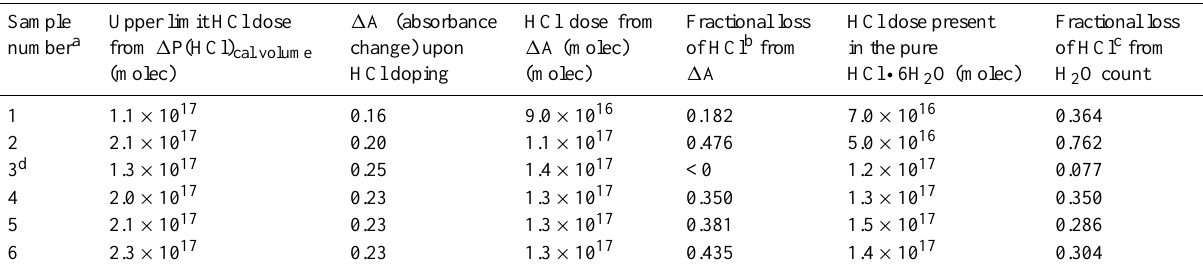
Table 4. Mass balance considerations. Comparison between the dispensed HCl dose obtained from the pressure decrease in the calibrated volume, the HCl dose calculated from the change in the IR spectrum and the HCl dose present when a pure HCl assuming a 6:1 H 2 O to HCl composition.